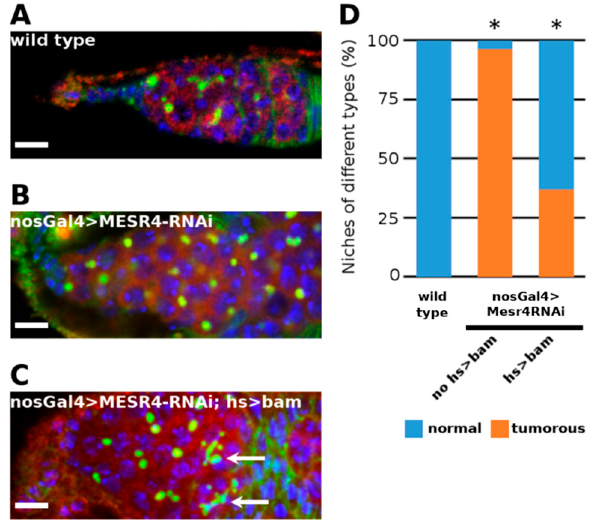
Figure 3. Rescue of MESR4 silencing by forced bam expression. ( A – D ) Immunostaining a wild type ( A ) and a tumorous nosGal4 > MESR4 -RNAi niche ( B ). Rescue of the niche defects in a nosGal4 > MESR4 -RNAi; hs > bam niche after heat shock ( C ). Fusomes of differentiated germ cells are indicated by white arrows. Spectrosomes and fusomes are labelled with HTS (green); germ cells are labelled for Vasa (red); DAPI is blue. Scale bars: 10 µm. ( D ) Quantification of niche phenotypes of wild type (n = 27), nosGal4 > MESR4 -RNAi (n = 25) and nosGal4 > MESR4 -RNAi; hs > bam (n = 27) niches. “Normal” niches contain 1 to 6, “tumorous” niches contain more than 6 spectrosome containing germ cells. For statistical analysis, the Chi-square test was used, * p < 0.05.